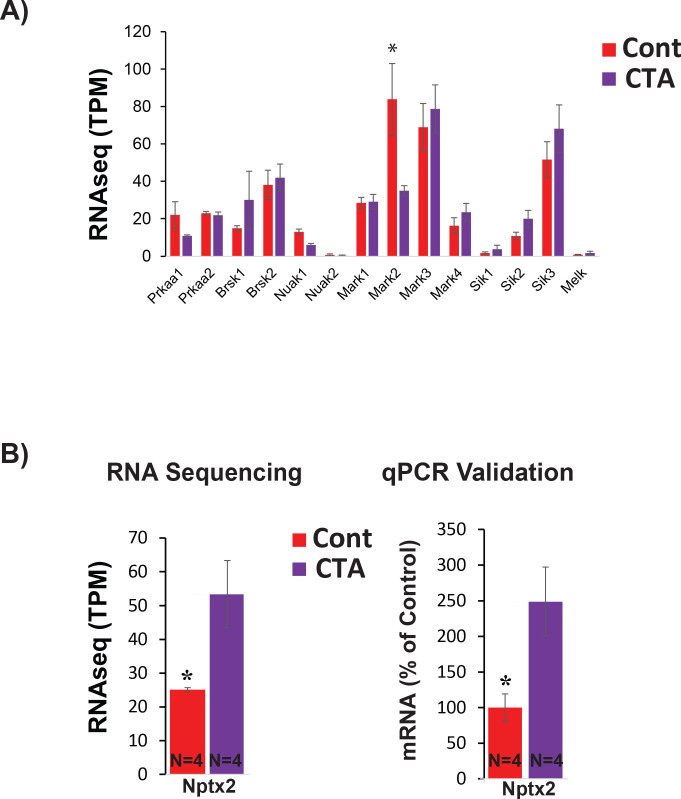
BLApn express known downstream targets of STK11 and C-FOS.(A) BLApn transcript levels of known downstream substrates of STK11, the members of the AMP-related kinase family (Lizcano et al., 2004). RNA sequencing from BLApn 4 hr following CTA training. Note that Mark2 mRNA expression is reduced in taste control mice relative CTA-trained mice (N = 4/group; *p<0.05); TPM- transcripts per million. (B) Nptx2, a known target of transcriptional regulation by C-FOS in neurons (Malik et al., 2014), increased following CTA. RNA sequencing (left) and qPCR validation (right) from BLApn 4 hr following CTA training. (N = 4/group; *p<0.05).